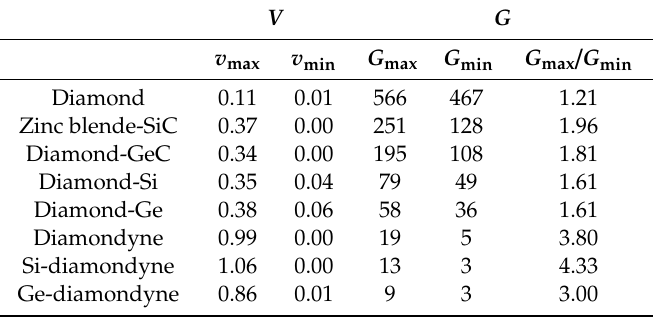
Table 4. The maximum values and the minimum values of Poisson’s ratio, shear modulus (in GPa) and G max / G min in primary planes for diamond, zinc blende-SiC, diamond-GeC, diamond-Si, diamond-Ge, diamondyne, Si-diamondyne and